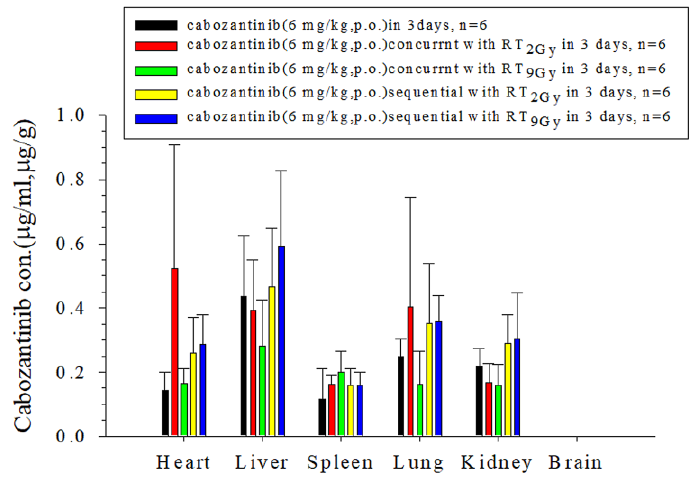
Figure 3. The concentration of cabozantinib in the heart, liver, spleen, lung, kidney and brain of rats after the administration of cabozantinib (6 mg/kg p.o., q.d.) with or without radiotherapy. The cabozantinib concentration units in the organs are expressed as µ g/mL or µ g/g (n = 6 per group). Table 2. Concentrations of cabozantinib in the heart, liver, spleen, lung, kidney and brain of rats after administration (6 mg/kg, p.o.) with or without radiotherapy. RT 2Gy RT